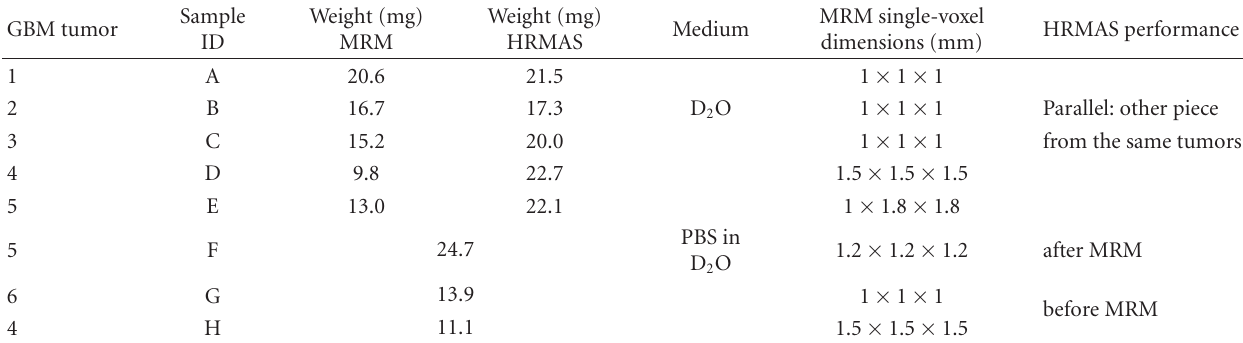
Table 1: MRM and HRMAS experiments for each tumor and